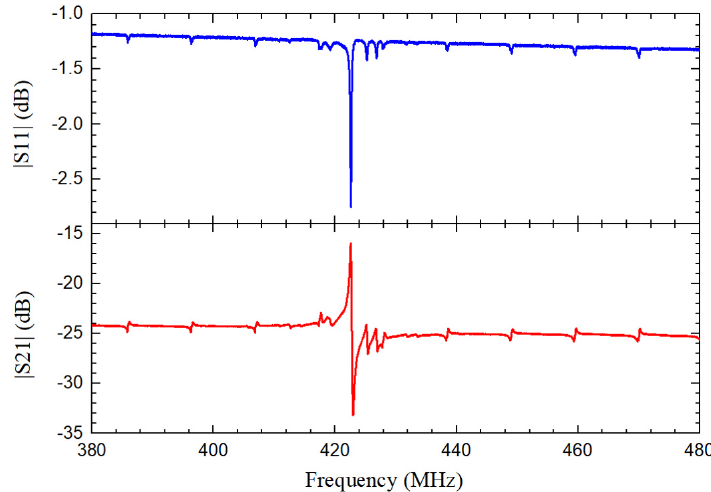
Figure 5. Measured S11 and S21 curves of the QSAW resonator with λ of 10.4 µ m in a wide frequency range from 380 MHz to 480